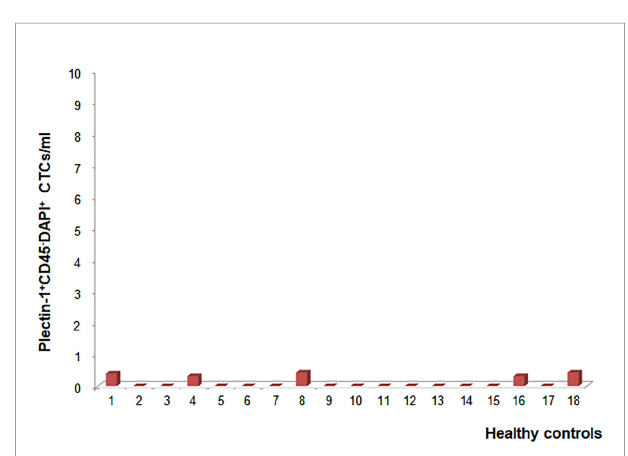
FIGURE 3 | Optimizationandvalidationof Plectin-1inhealthycontrols. To validate thespeci fi city ofPlectin-1 antigenindetecting circulating tumor cells(CTCs), the number of CTCswas countedinperipheralbloodsamplesof eighteenhealthy volunteers after immunostainingwithanti-Plectin-1andanti-CD45antibody. Plectin-1 + CD45 - DAPI + CTC counts per 1 ml